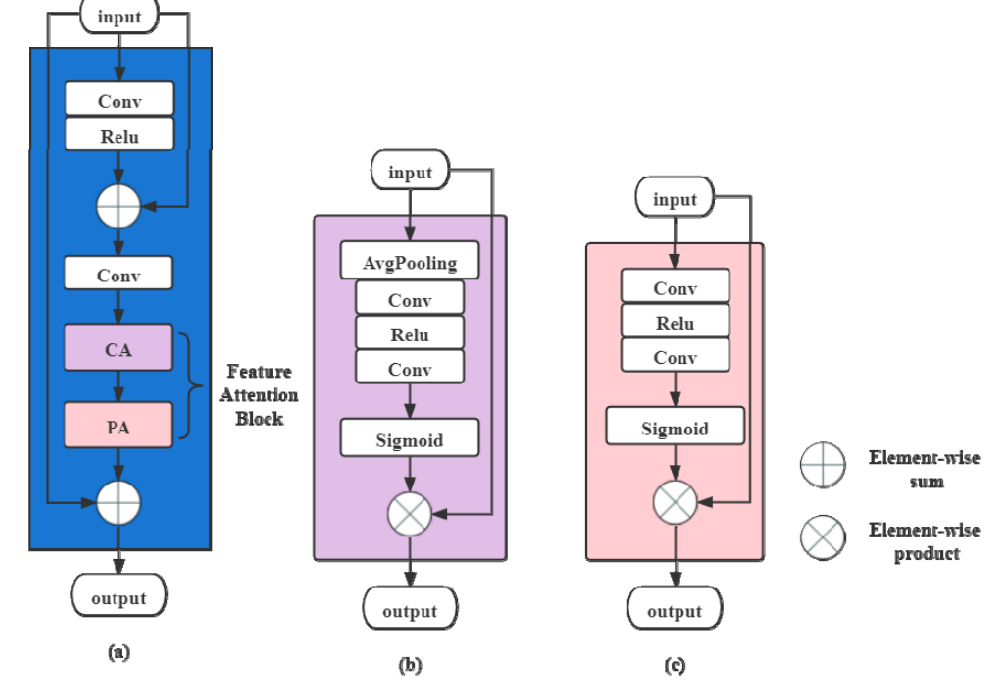
Figure 6. ( a ) Basic Attention Block (BAB); ( b ) Channel Attention (CA); and ( c ) Pixel Attention